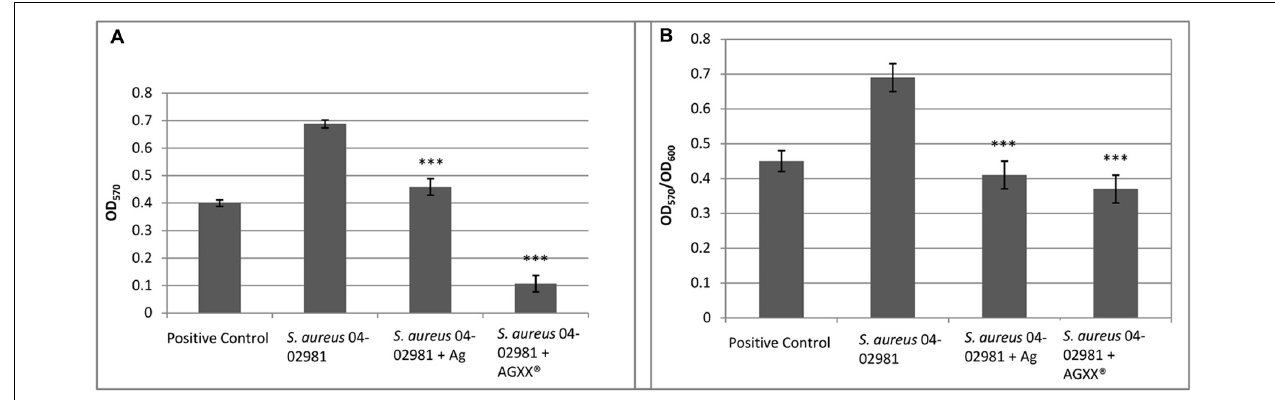
formation of S. aureus 04-02981 by 46%, whereas the inhibitory effect of Ag on biofilm formation was less pronounced